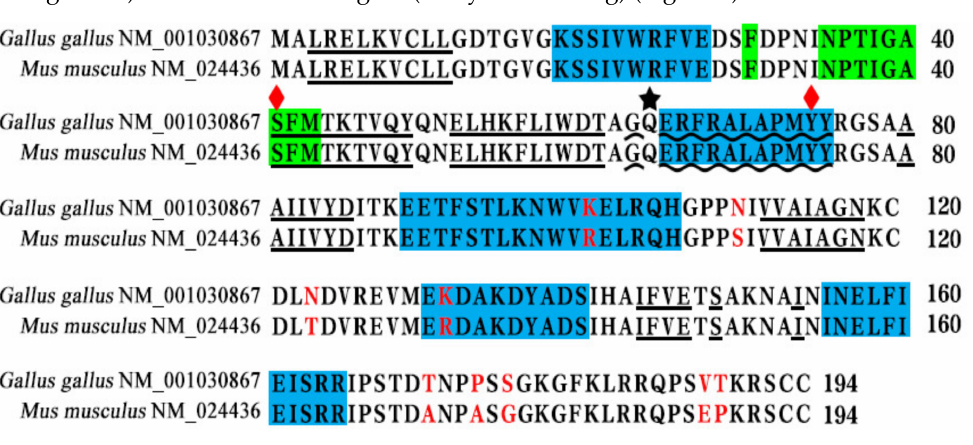
Figure 1. Aligned amino acid sequences of cRab22a and mRab22a indicated that Red-labeled rep- resents mutated ones; underlining indicates β -folds; blue background indicates α -helices; green background indicates the Switch I area; wavy underlining indicates the Switch II area; black star (cid:70) indicates GTP-binding site; red diamonds indicate the point